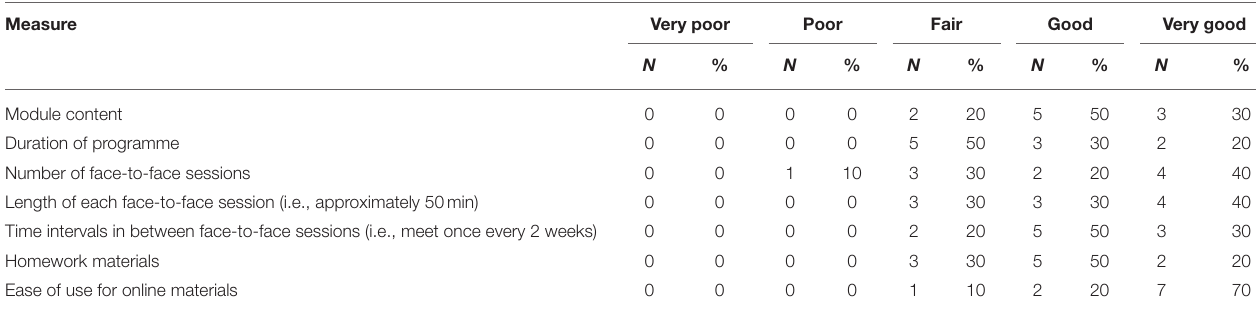
TABLE 4 | Treatment satisfaction with the programme. Measure Very poor Poor Fair Good